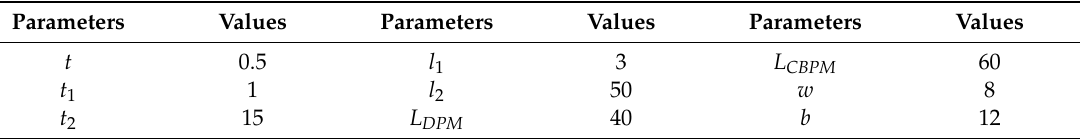
Table 2. Structural parameters of positioning stage.